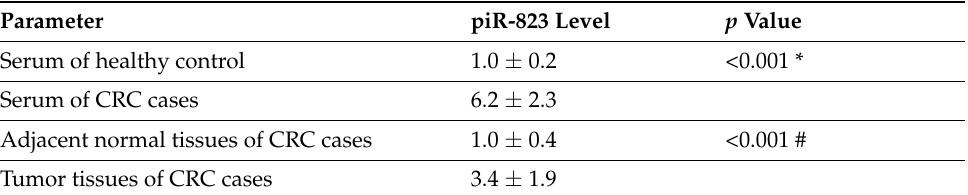
Table 2. P-element induced wimpy testis (PIWI) RNA-823 (piR-823) expression in colorectal cancer cases (CRC) and control subjects.